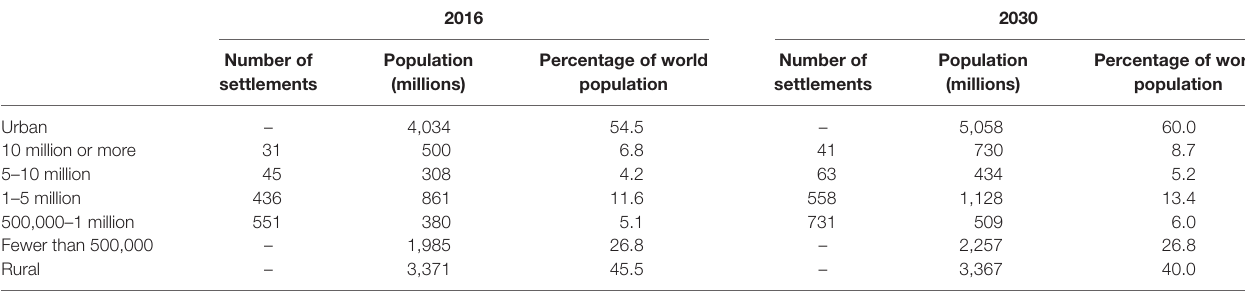
taBle 1 | The growth in the world’s population by size of city, 2016 and